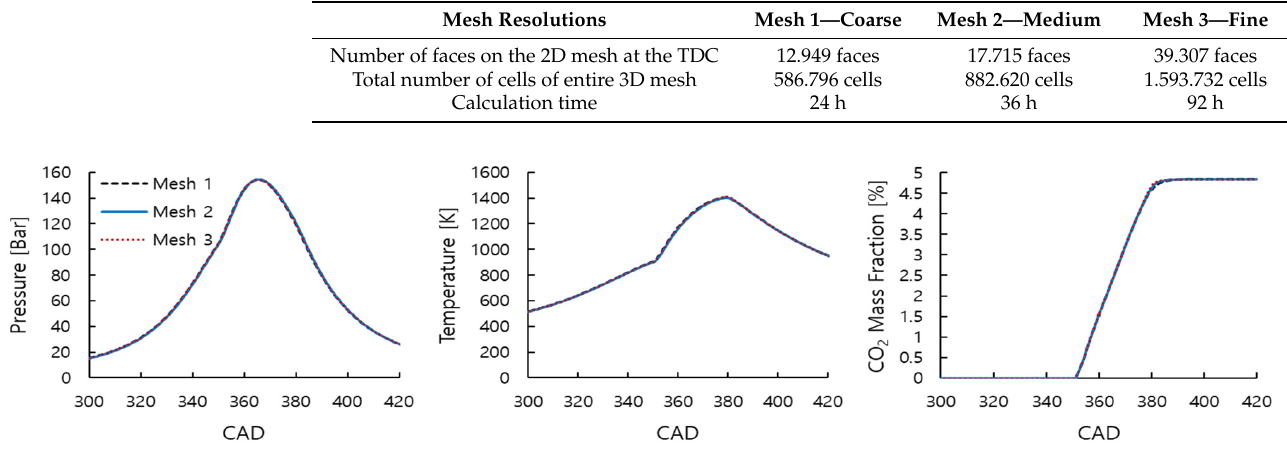
Figure 6. CFD results of the simulations using the three different mesh resolutions.